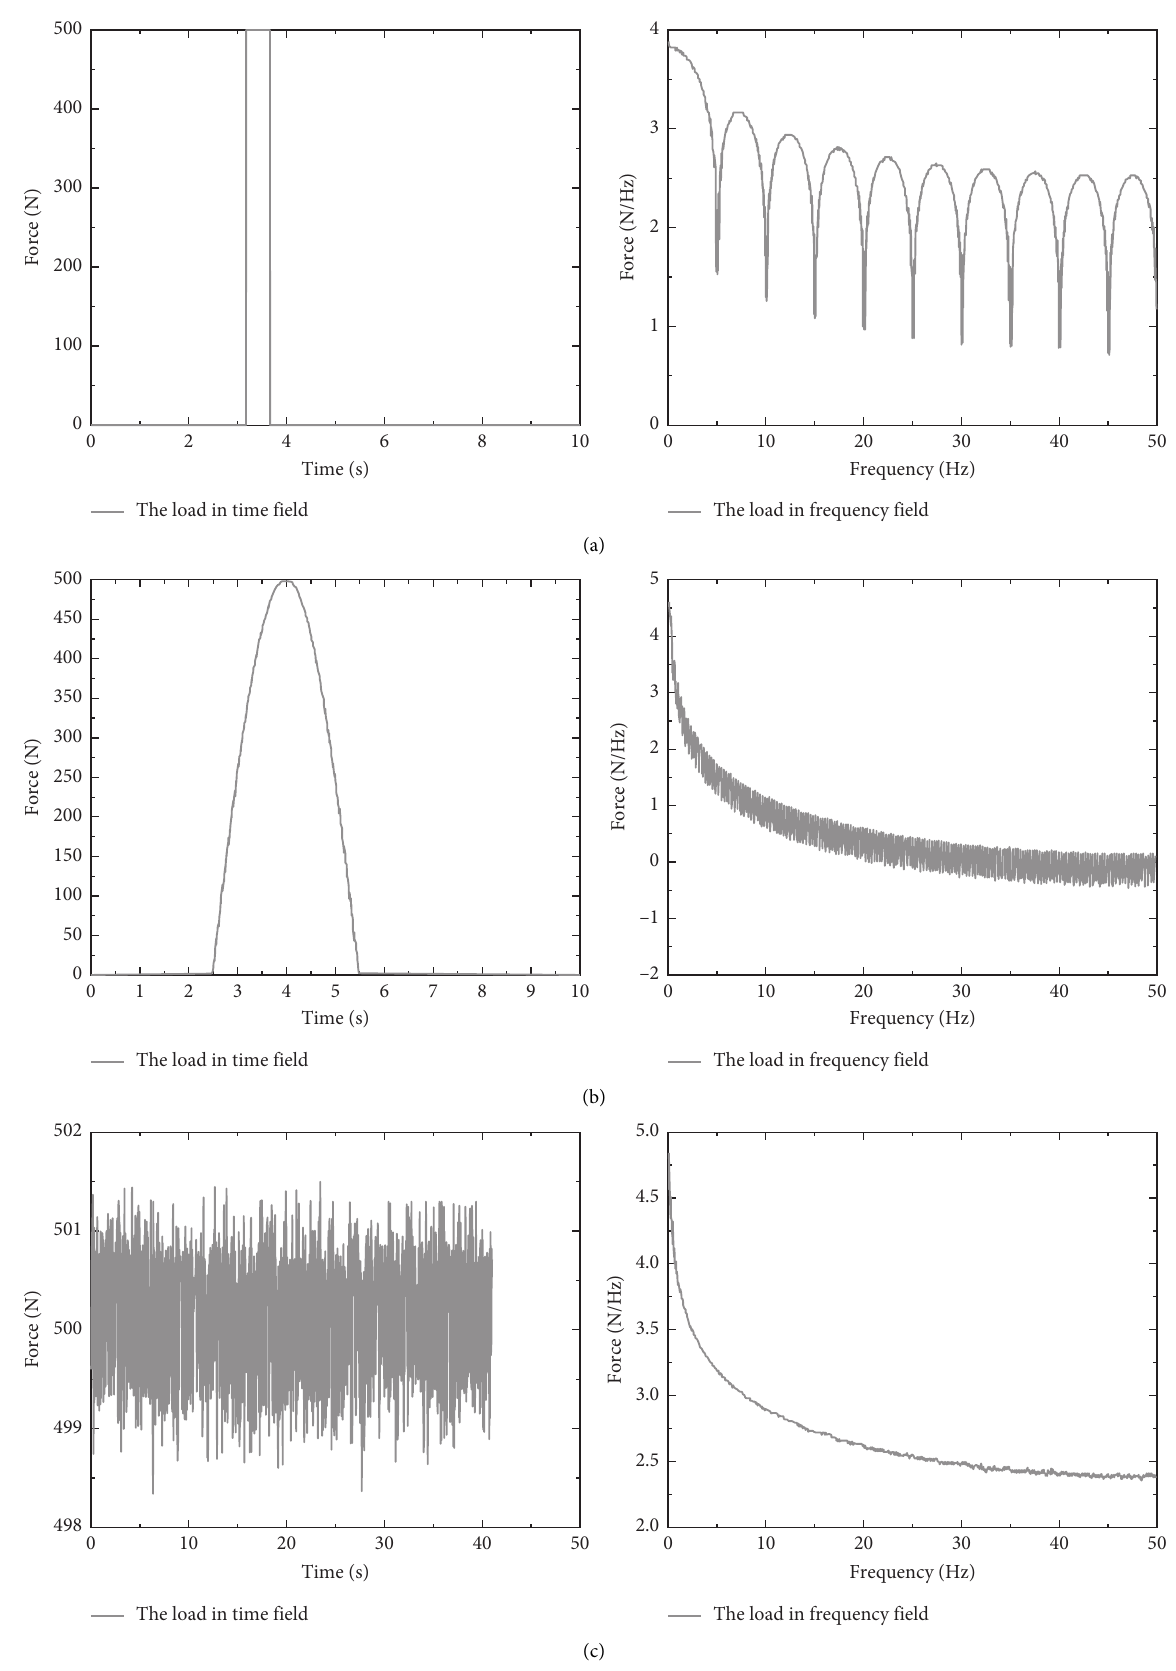
Figure 13: Force diagram: (a) case 1, (b) case 2, and (c) case